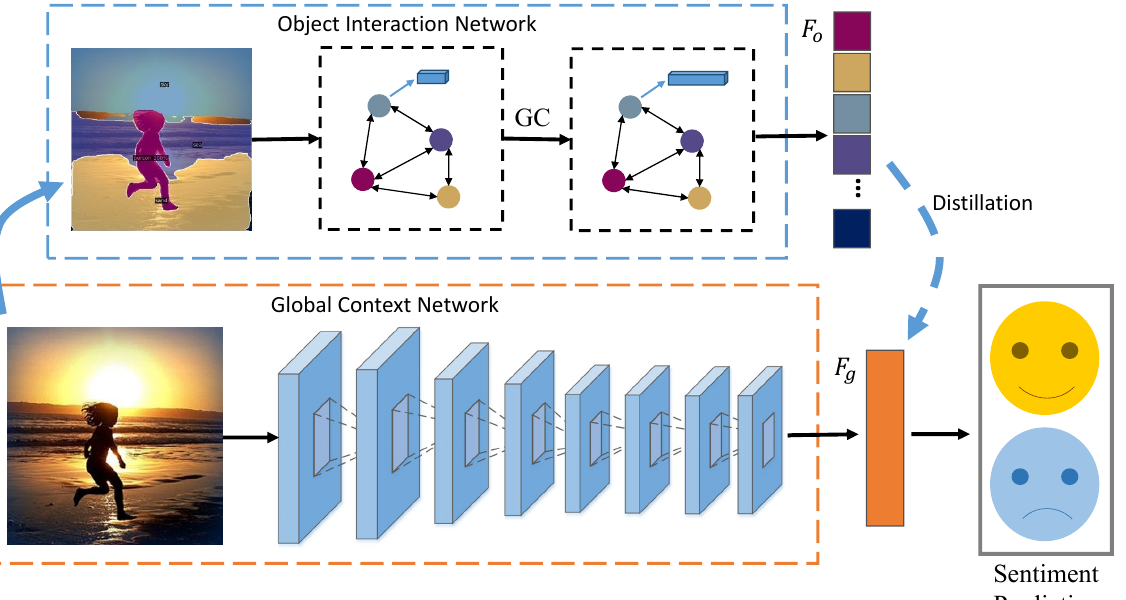
Figure 2. Overview of the Sentiment Interaction Distillation Network. During training, the object branch captures sentiment interaction information through the sentiment graph model, while the global context branch provides the context information. Then, the object information is distilled into the context feature. For testing, only the global context branch is needed for sentiment